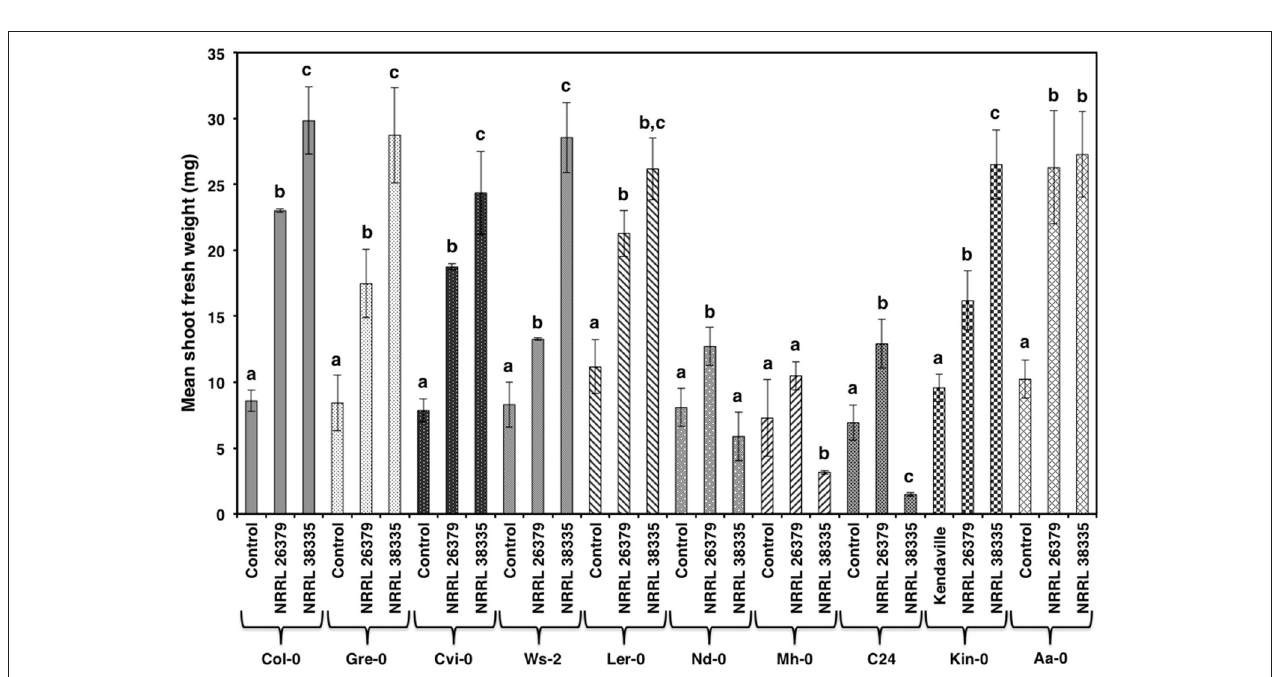
FIGURE 3 | Growth response of 10 A. thaliana ecotypes to F. oxysporum volatiles. The mean shoot fresh weight of each ecotype was measured after 2 weeks of cocultivation with no fungus (control), NRRL 26379, and NRRL 38335. Means and standard errors for six biological replicates per treatment, with five seedlings per replicate, are shown. Different letters on columns represent statistically significant differences within each ecotype by one-way analysis of variance. Photos of ecotype C24 after this experiment are shown in Supplementary Figure 1.